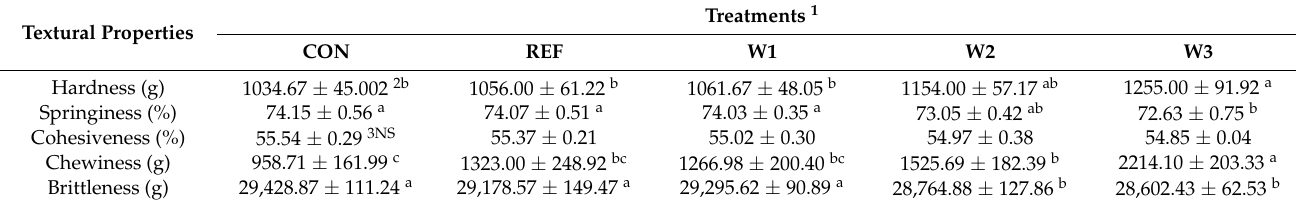
Table 8. Textural properties of Tteokgalbi prepared with watermelon radish powder.